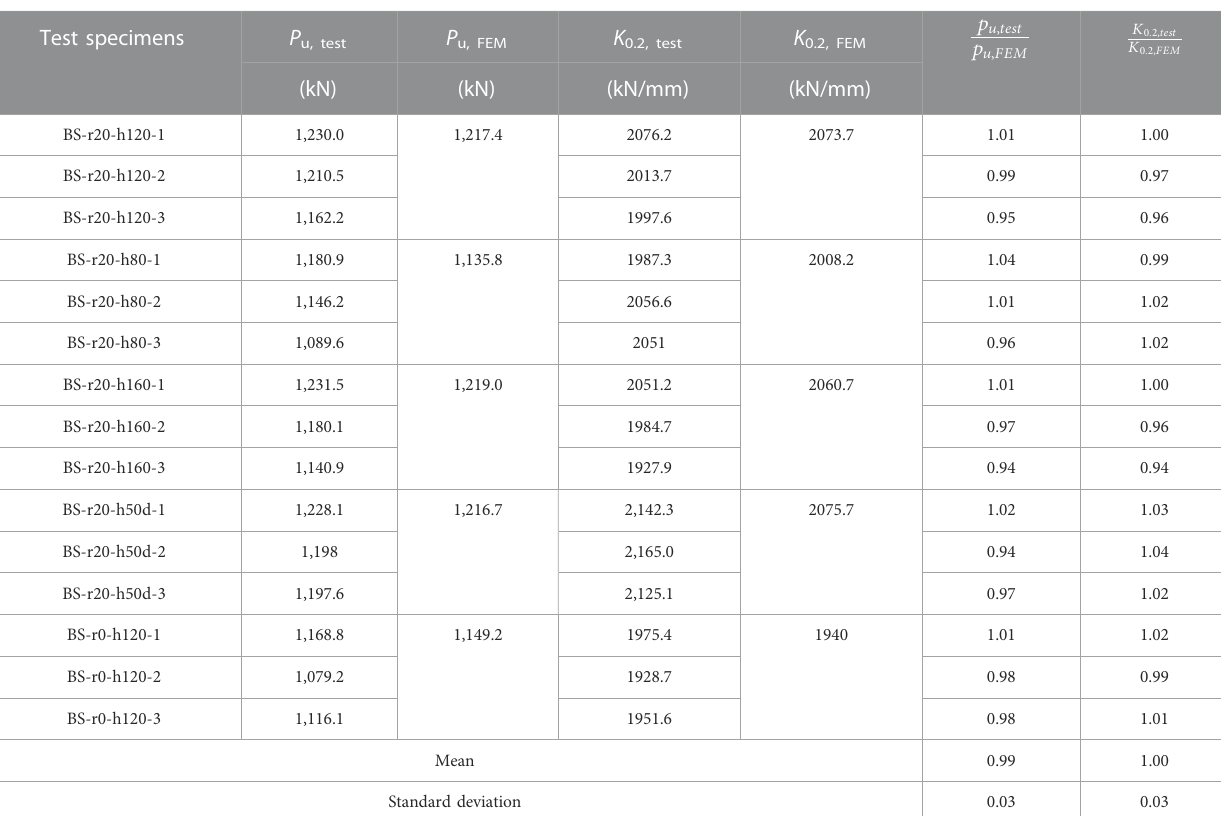
TABLE 3 Test results VS. FEM